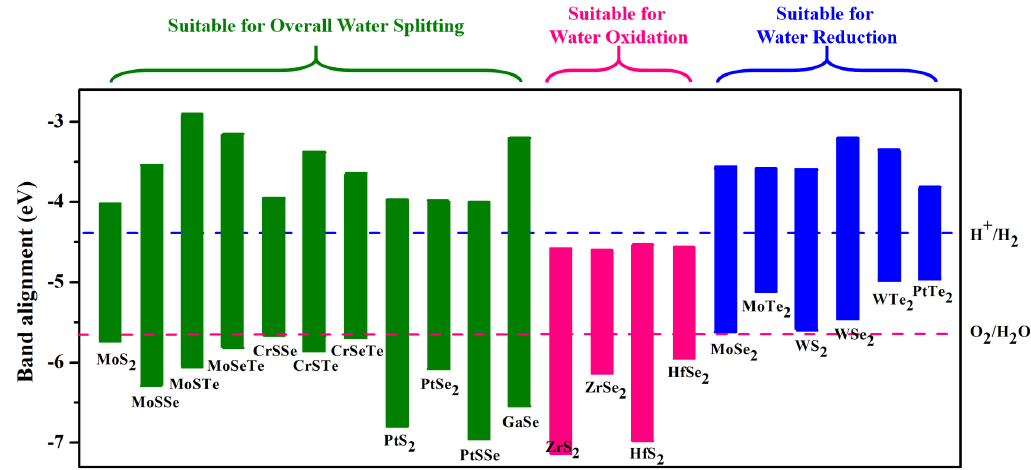
Figure 8. Band alignments of some typical 2D transition metal dichalcogenides with respect to the water reduction and oxidation potential for photocatalytic water splitting. The band alignments data are from references